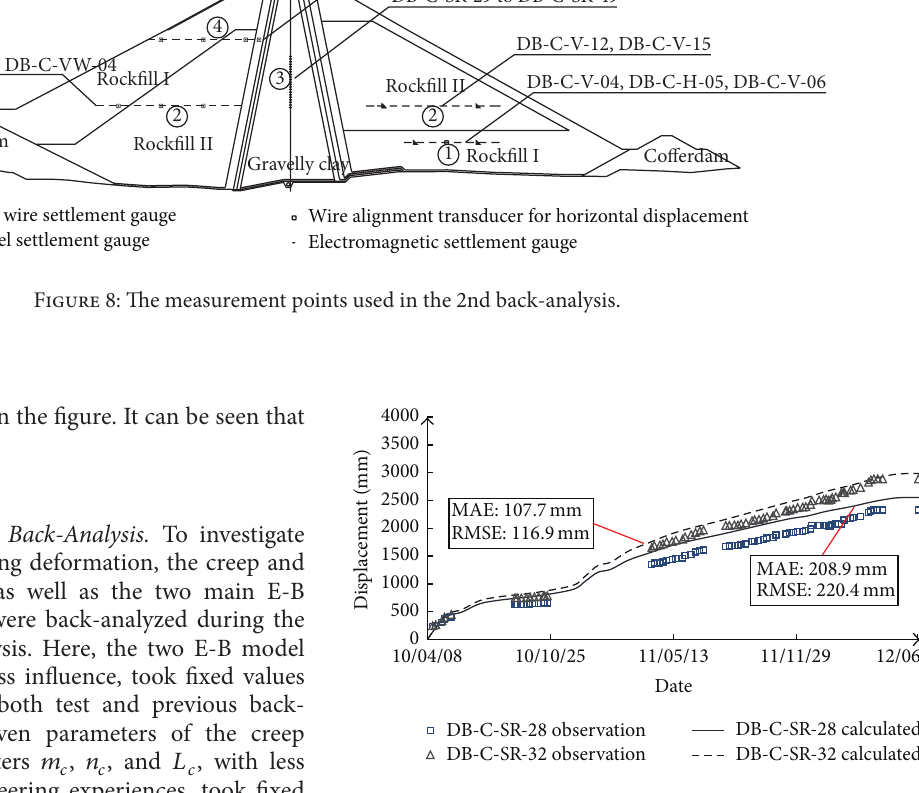
Figure 9: Comparison between calculated results (2nd back-analy- sis parameters) and observation